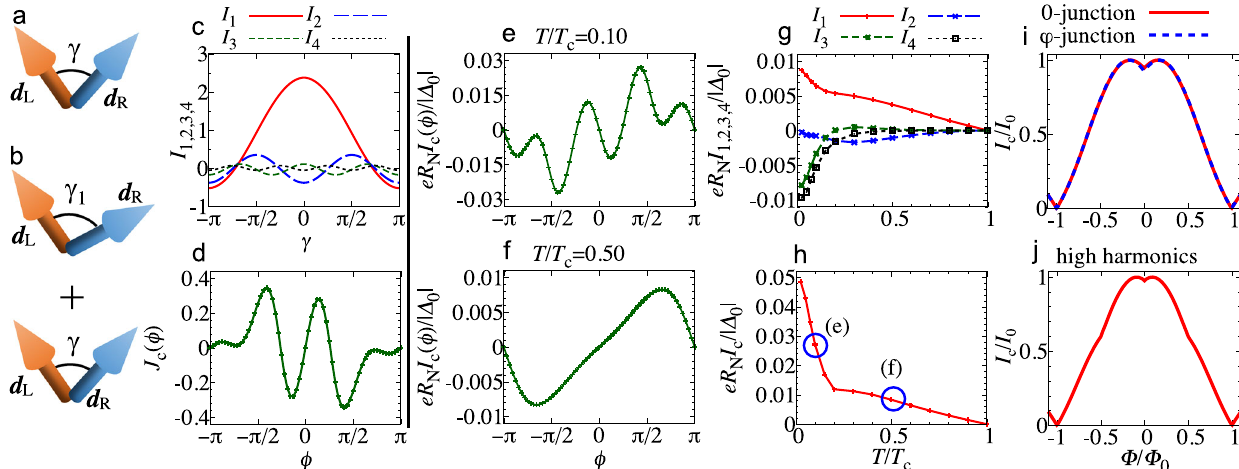
Fig. 3 Misalignement of d -vectors, high-harmonics in the current phase relation and magnetic fi eld dependence of the critical current. a Sketch of the d -vectors on the left (L) and right (R) sides of the junction with a misaligned angle γ . b Schematic illustration of two Josephson channels with misaligned angles γ and γ 1 for the d -vectors. c The behavior of the fi rst four harmonics amplitude ( I n with n = 1, . . . , 4) of the Josephson current in the case of two Josephson channels, characterized by a varying misalignment angle ( γ ) and a given one ( γ 1 = 0.24 π ) for the corresponding d -vectors. The transmission amplitudes are Z t 1 = 0.85 and Z t = 0.95. d Current phase relation for two Josephson channels with Z t 1 = 0.85, Z t = 0.95, γ 1 = 0.24 π , and γ = 0.74 π . Current phase relation for the NCS-NCS junction at different temperatures evaluated by means of the recursive Green's function: e T / T c = 0.10 and f T / T c = 0.50. g Temperature dependence of the n = 1, 2, 3, 4 Josephson harmonics and h the maximum amplitude of the Josephson current. In e – h , we set parameters as T c / t = 1.0 × 10 − 5 , ( λ SOL / t , α ORL / t , μ L / t ) = (0.10, 0.20, 0.00), and ( λ SOR / t , α ORR / t , μ R / t ) = (0.10, 0.20, 0.35). Magnetic fi eld dependence of the critical current (Fraunhofer pattern) with an applied magnetic fl ux Φ threading the NCS-NCS junction for i 0- (red line) and φ -Josephson coupling (blue dotted line) as for the CPR in Fig. 2 d and h